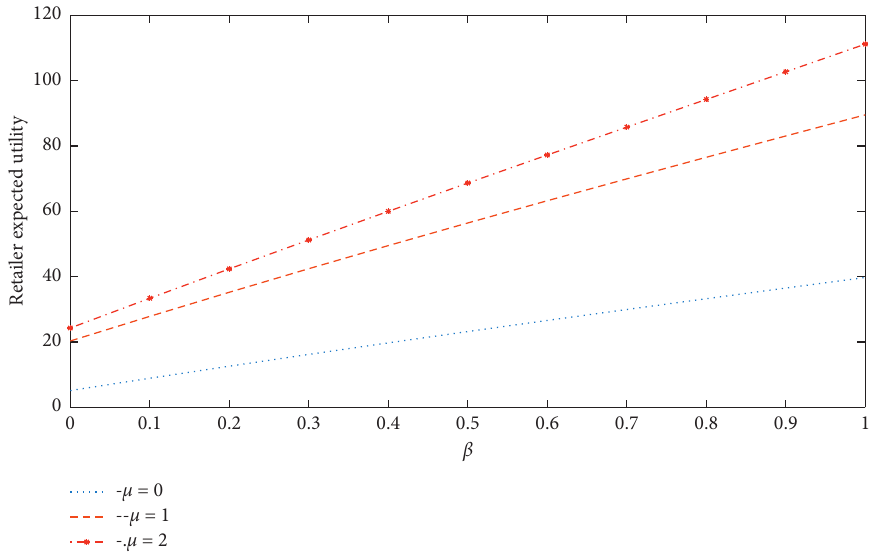
Figure 4: The effect of the cognitive biases on retailer utility.